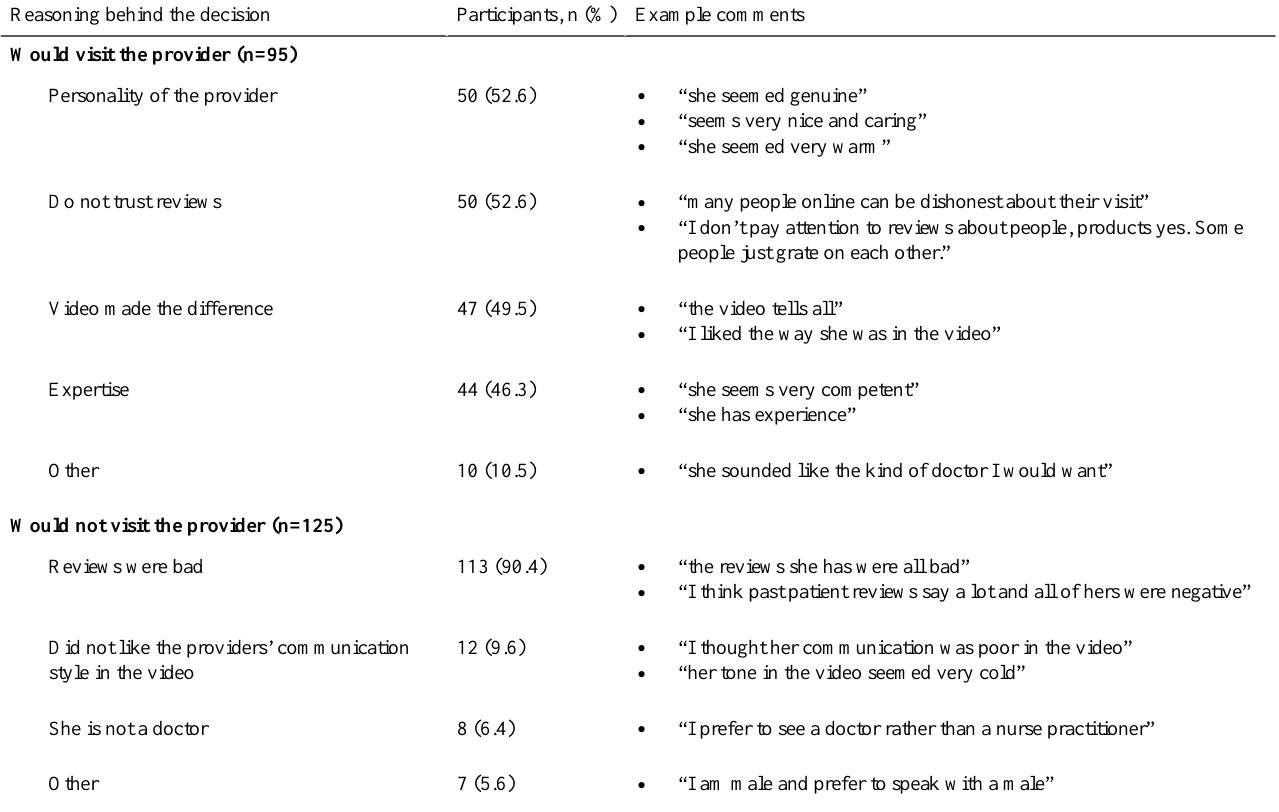
Table 4. Rationales for selection of participants exposed to all negative